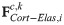
Schematic diagram of cell-ECM interaction.A: Each cell is represented by a mesh structure consisting of multiple nodes which are indicated by the yellow spheres. The ECM is modeled as a network of many fibers connected through a large number of nodes. The i-th membrane node is attached to the j-th ECM node through a focal adhesion connection. B: The forces acting on each membrane node include the cortical tension and membrane elastic energy force (FCort-Elas,ic,k), focal adhesion force (FFA,ic,k), lamellipodium force (FL,ic,k), and frictional damping force(FDamp,ic,k). The forces acting on each node within the ECM fiber network include the elastic energy force (FElas,je), focal adhesion force (FFA,je), and damping force (FDamp,je).